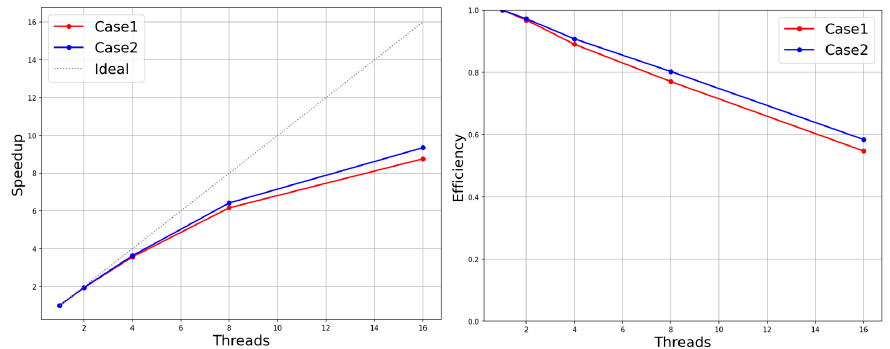
Figure 23. Speed-up and efficiency in the two different groups of grid